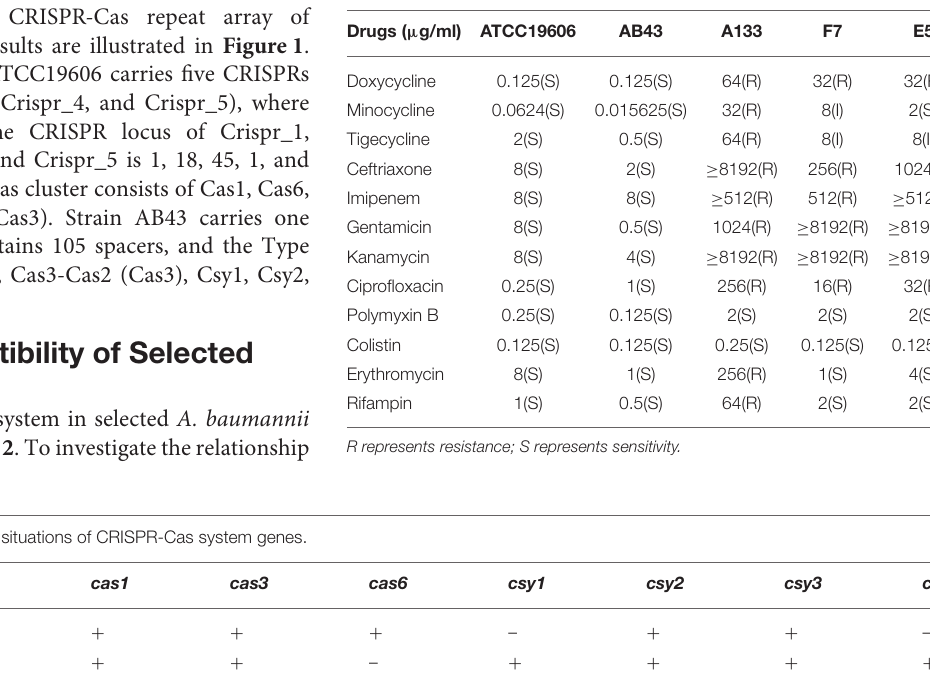
TABLE 3 | Minimum inhibitory concentrations (MICs) of strains with different types of CRISPR-Cas system.